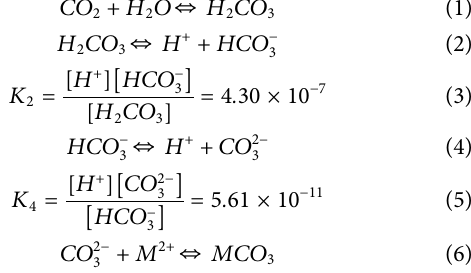
Frontiers in Bioengineering and Biotechnology |